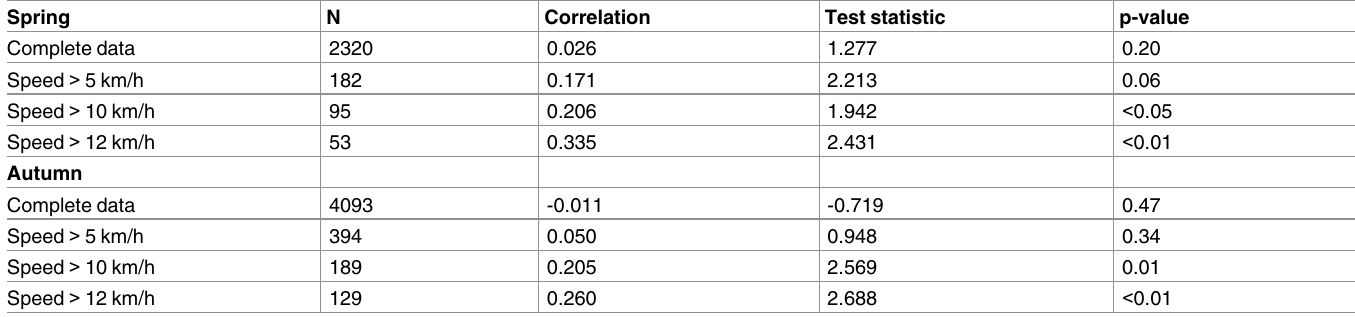
Table 2. Circular correlation coefficients between the flying direction of the Americanwhite pelicans and the encountered wind direction at each given recorded location. Results are shown for each season using the completedataset and three different speedthresholds. Spring N Correlation Test